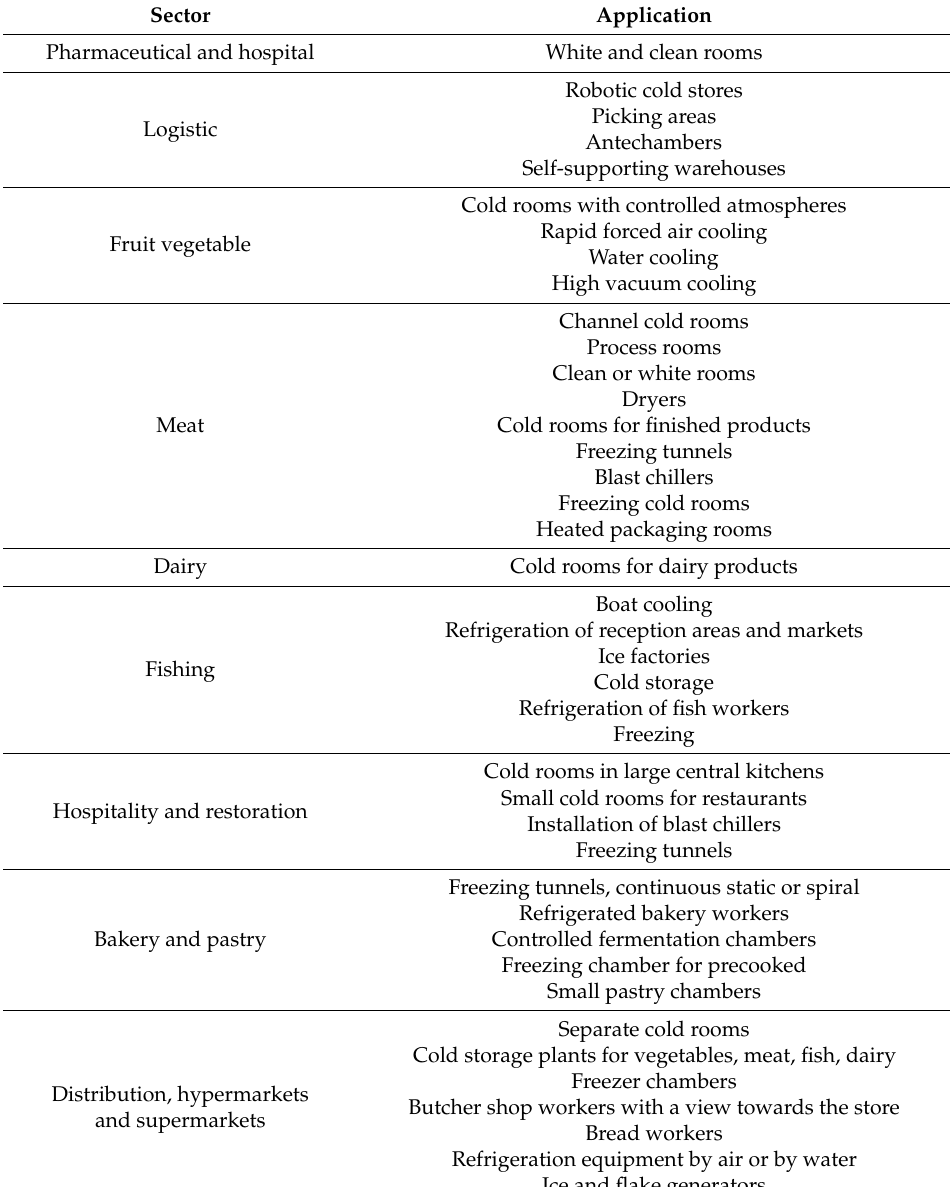
Table 1. Industrial cold applications by type of industrial